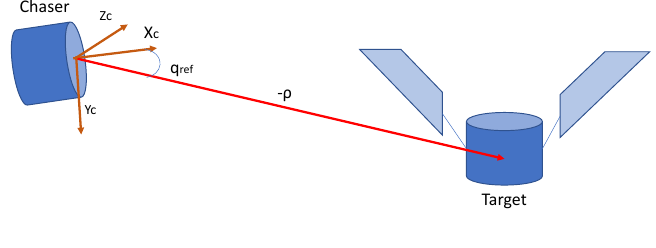
Figure 25. Target pointing